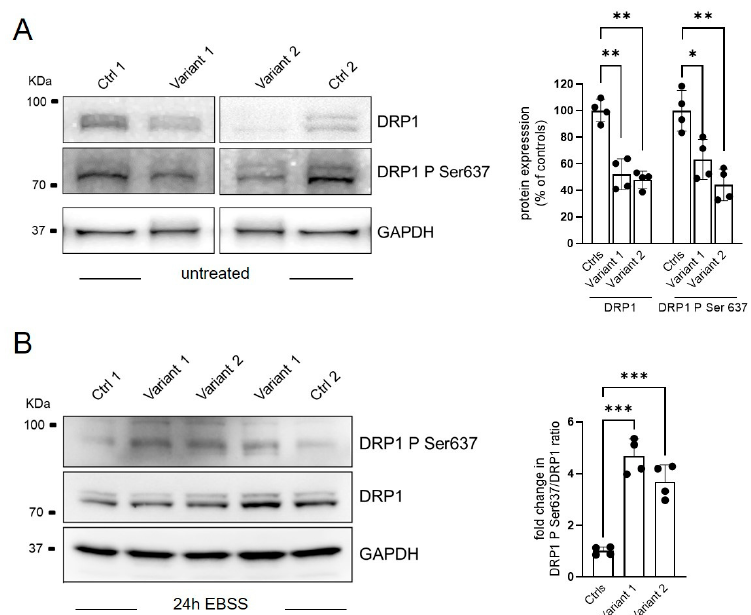
Figure 2. Cellular analysis of mitochondrial function. ( A ) Micro-oxygraphy track showing a reduced OCR in mutated cell lines, which is clearly evident after FCCP injection, reflecting a deficient spare respiratory capacity. Data represent mean ± SEM of controls ( n = 3) and patients ( n = 2 for each mutation). Two independent experiments were run with four technical replicates for each cell line. ( B – C ) Mitochondrial membrane potential profiles evaluated both in terms of TMRM probe accumulation and membrane potential maintenance. ( B ) End-point assay indicating a mitochondrial membrane depolarization in mutated fibroblasts reported as percentage of controls. Data were normalized by DAPI staining as a function of cell number. ( C ) Kinetic track demonstrates the ability of REEP1 cultured skin fibroblasts to maintain polarized mitochondrial membrane after oligomycin blocking proton transit through Complex V, highlighting any leakage of the inner mitochondrial membrane. FCCP was added at the end of the experiments to fully depolarized mitochondrial to demonstrate the specificity of measurements. Data represent mean ± SEM of controls ( n = 3) and patients ( n = 2 for each mutation). A technical triplicate was assessed for endpoint assay, whereas for kinetic analyses, cell lines were acquired in an independent experiment recording 10 different ROIs/field over time. For all the reported experiments, statistics were assessed by ordinary ANOVA test (one-way ANOVA). * p < 0.05; *** p < 0.001. Alterations of mitochondrial morphology have been previously described in different forms of HSP. In particular, REEP1 dysfunction in SPG31 directly affected mitochondrial dynamics by the inhibition of mitochondrial fission protein, DRP1, due to the hyperphosphorylation of its serine 637 residue [11]. A reduced expression of DRP1 was observed by WB also in our cells (Figure 3A), whereas the steady-state levels of OPA1, MNF2, and FIS1, additional proteins involved in mitochondrial dynamics, were similar to those observed in control fibroblasts (see Supplementary Figure S1). To evaluate the fusion activity of DRP1, DRP1–Ser-637 phosphorylation was triggered by the cAMP-dependent protein kinase A (PKA) activation via 24-h starvation treatment in the EBSS medium. An unbalanced ratio between total DRP1 and its Ser 637-phosphorilated form was observed in both mutant cell lines demonstrating a specific DRP1 hyperphosphorylation associated with REEP1 defect (Figure 3B).